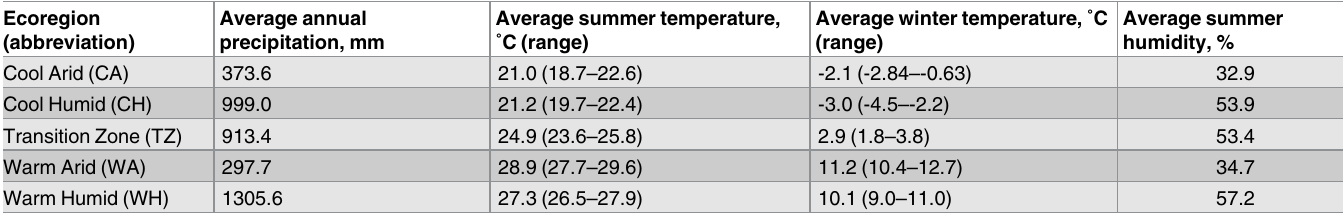
Table 1. Climatic variables for five ecoregions within the United